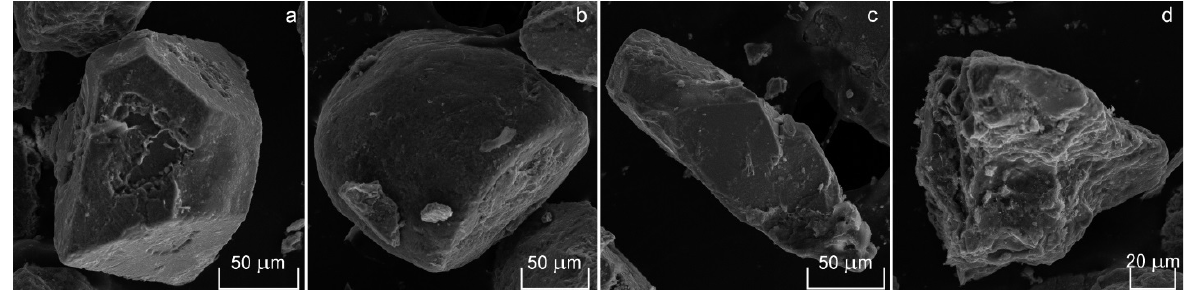
Figure 11. Morphology of chromian spinel grains from the Bazilevo paleoplacer (SE images): ( a )—truncated octahedron (group II), ( b )—segment of myriohedral grain (group III), ( c )—defective columnar rhombohedron-shaped grain (group IV), ( d )—xenomorphic highly corroded grain (group VI).